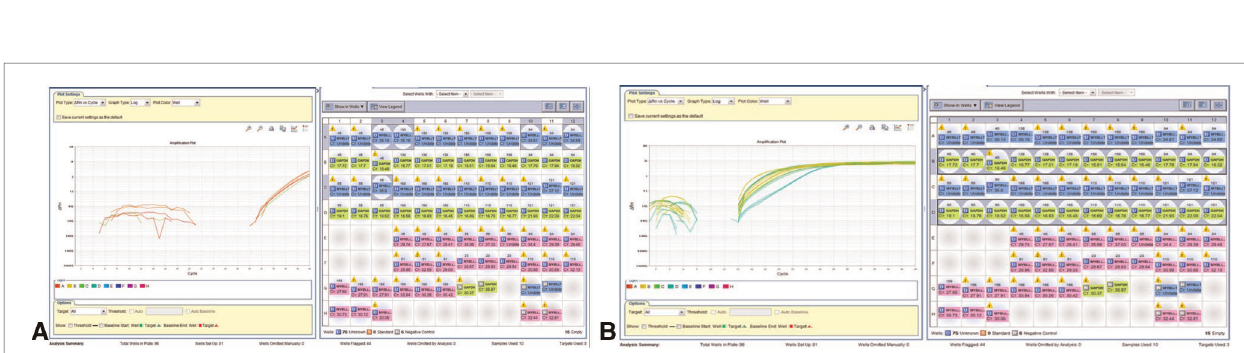
FIGURE 5 | Positive MYBL1-trunc2. ( A ) Detection of MYBL-1 trunc 2 positive samples are shown:50(45), 58(138), 60(55), 52(84). Negative 4 samples: 54(158) PXA, 168 ODG, 53 (110) PMA, and 121 PXA. ( B ) Expression of normalized GAPDH gene in grade II gliomas